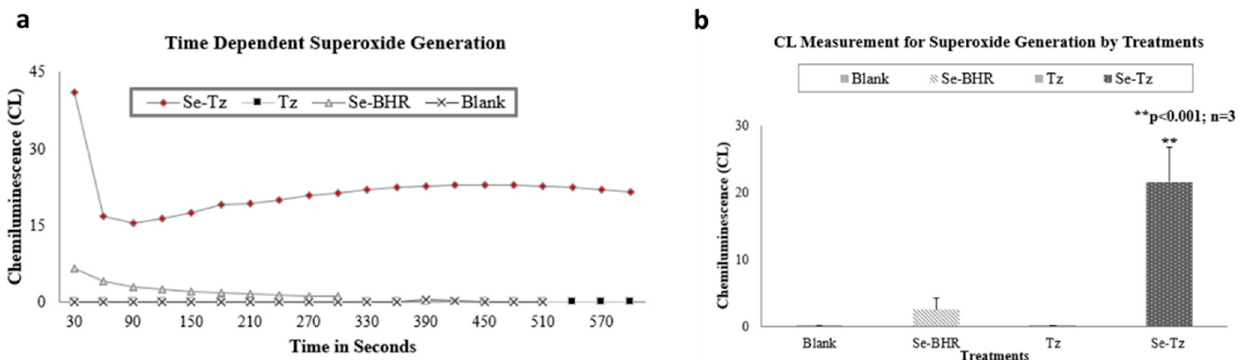
Figure 3. ( a ) O 2• − CL generated by treatments over time. Figure ( b ) is the sum total of O 2• − CL generated by each of the treat ‐ Figure 3. ( a ) O 2 •− CL generated by treatments over time. Figure ( b ) is the sum total of O 2 •− CL generated by each of the ments over 5 min. For the measurement of superoxide generation, 330 μ L of Se ‐ Tz was added to 500 μ L of CL cocktail and treatments over 5 min. For the measurement of superoxide generation, 330 µ L of Se-Tz was added to 500 µ L of CL cocktail similar steps were followed for the native Tz (330 μ L) and Se ‐ BHR (50 μ L) in PBS. Mean CL generation by Se ‐ BHR (20 mg/mL), and similar steps were followed for the native Tz (330 µ L) and Se-BHR (50 µ L) in PBS. Mean CL generation by Se-BHR Tz (protein concentration 3 mg/mL) and Se ‐ Tz (protein concentration 3 mg/mL) was 2.53 ± 1.68, 0.05 ± 0.036 and 21.5 ± 5.17 (20 mg/mL), Tz (protein concentration 3 mg/mL) and Se-Tz (protein concentration 3 mg/mL) was 2.53 ± 1.68, 0.05 ± 0.036 CLU (** p < 0.001), respectively. and 21.5 ± 5.17 CLU (** p < 0.001),